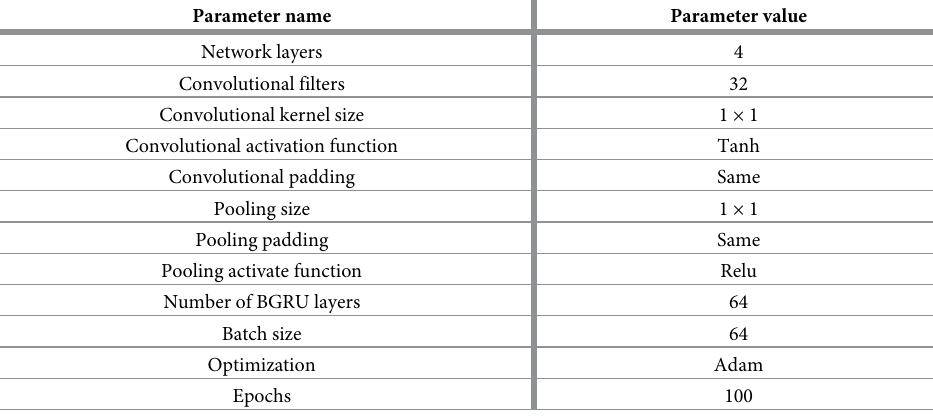
From Table 7, we can see that with the increase of the number of units, the prediction accu- racy of common stocks becomes higher and higher. When the number of units reaches 64, the error is the smallest, which is also consistent with the prediction of index stocks in Table 6. Because this paper is based on the hybrid model of FS-CNN-BGRU, after obtaining the best number of CNN and LSTM units, the number of GRU and BGRU units is set to 64, so in the next experiment, the number of convolution cores of CNN is finally selected as 32, and the number of units in BGRU is selected as 64 to ensure the correctness and unity of the experiment. Table 8 shows the parameters of FS-CNN-BGRU model. The model is divided into four lay- ers: input layer, convolution layer, BGRU layer and output layer. The convolution layer is set to 1 layer, the number of convolution cores is 32, the size of convolution core is 1 × 1, stripe is set to 1, padding is the same, Tanh is used as the activation function, Max-Pooling is used as the Pooling layer, padding is set to 1, and Relu is used as the activation function. The bidirec- tional GRU is set to 1 layer with 64 units. The BGRU network time step is set to 50 to predict the closing price of the 51st day. The gradient descent algorithm uses Adam and iterates 100 times. Table 8. Parameters of FS-CNN-BGRU